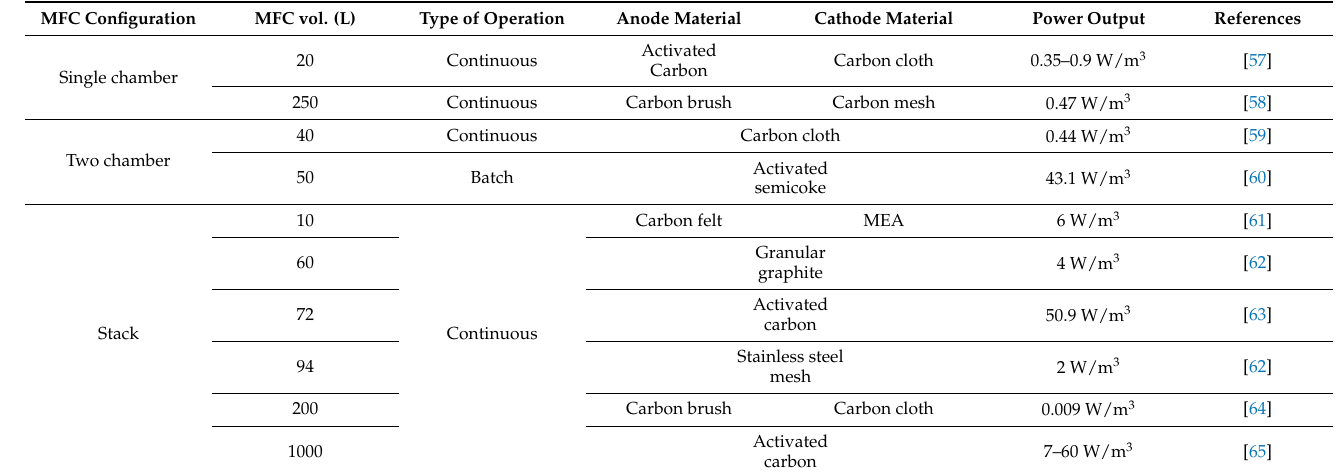
Table 1. Various materials utilized in MFC configuration and